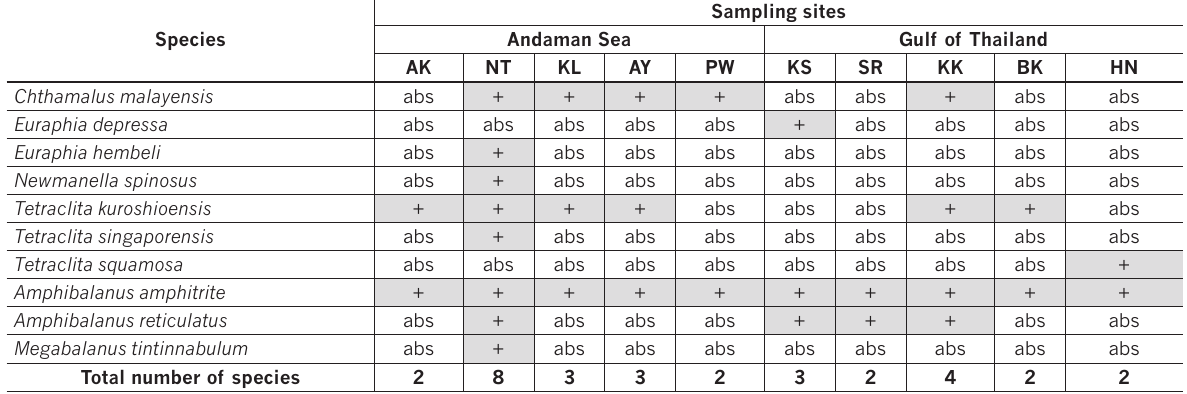
Table 2. Species list and distribution of acorn barnacles found in ten sampling sites along the coastlines of the Andaman Sea and the Gulf of Thailand. Abbreviations: +, presence; abs, absence. See Table 1 for acronyms of sampling